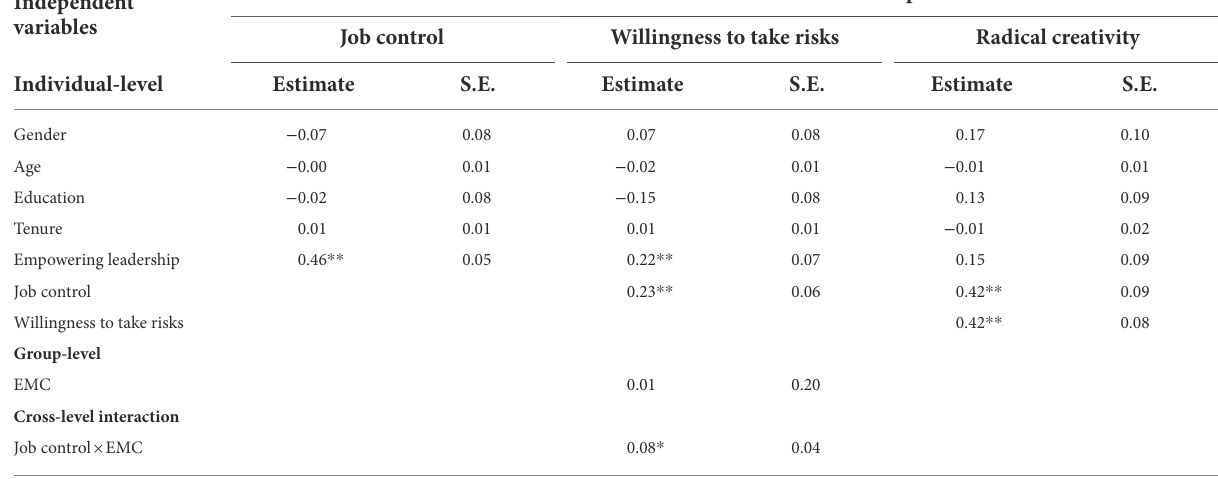
TABLE 2 Results of the path